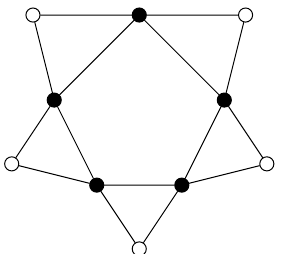
√ 8 n + 1 + 1 ( G ) ≥ 2 2 t